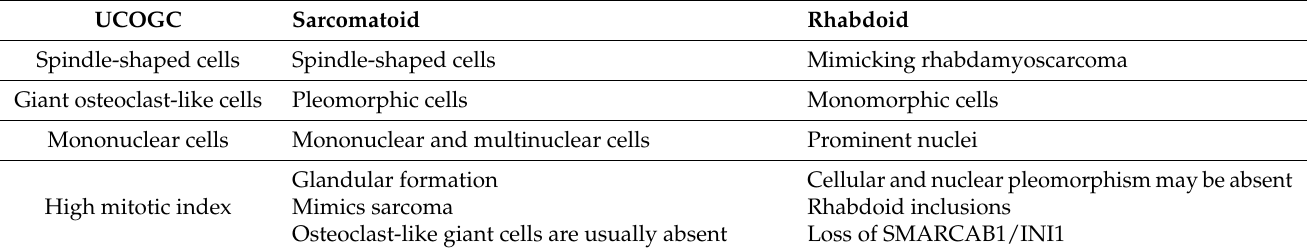
Table 1. Histopathological characteristics of undifferentiated pancreatic tumors.